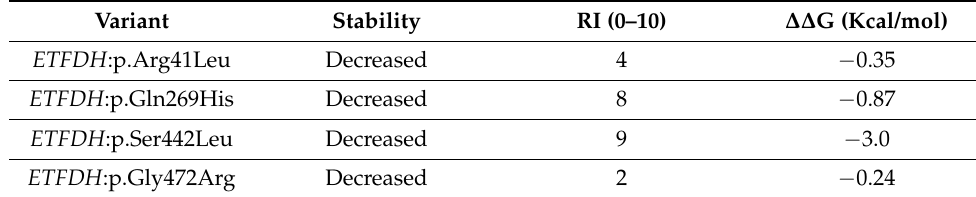
Table 4. I-mutant Suite based prediction of protein